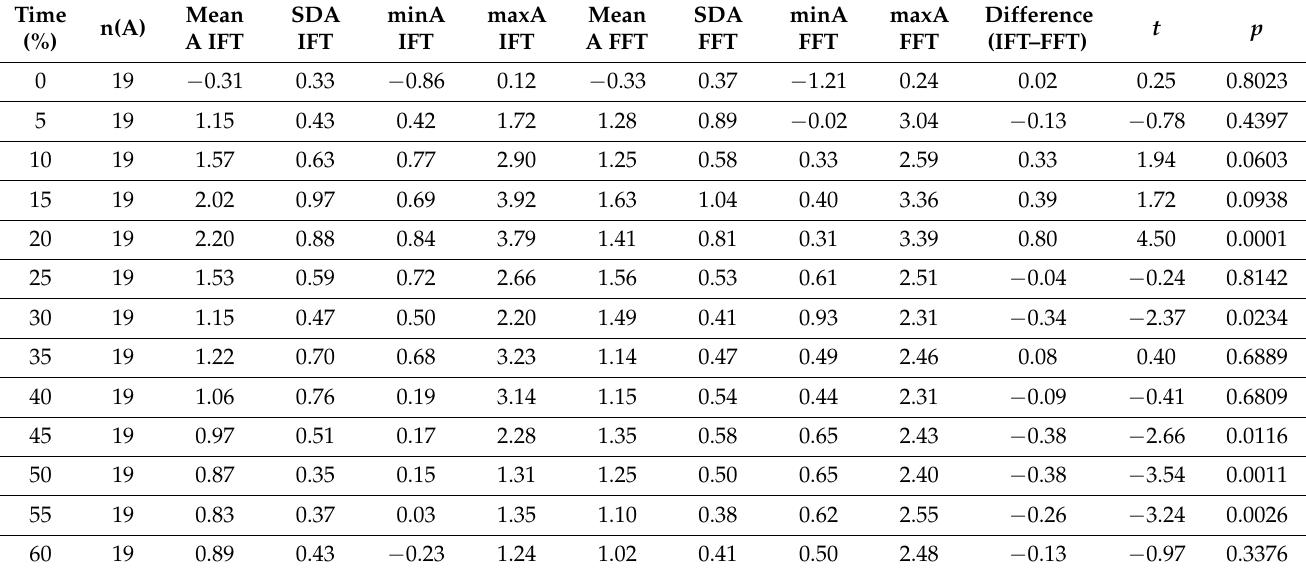
Figure 6. Dependence of mean values of linear head acceleration in the sagittal plane on the time of performing a backward fall in the form of IFT and FFT in group B, which consisted of students who played handball. Table 1. Basic characteristics (number of observations n, mean, standard deviation SD, max and min) for IFT and FFT for group A. For each time point, the differences between IFT and FFT and Student’s t -tests were calculated for dependent variables; it was checked whether this was significantly different from